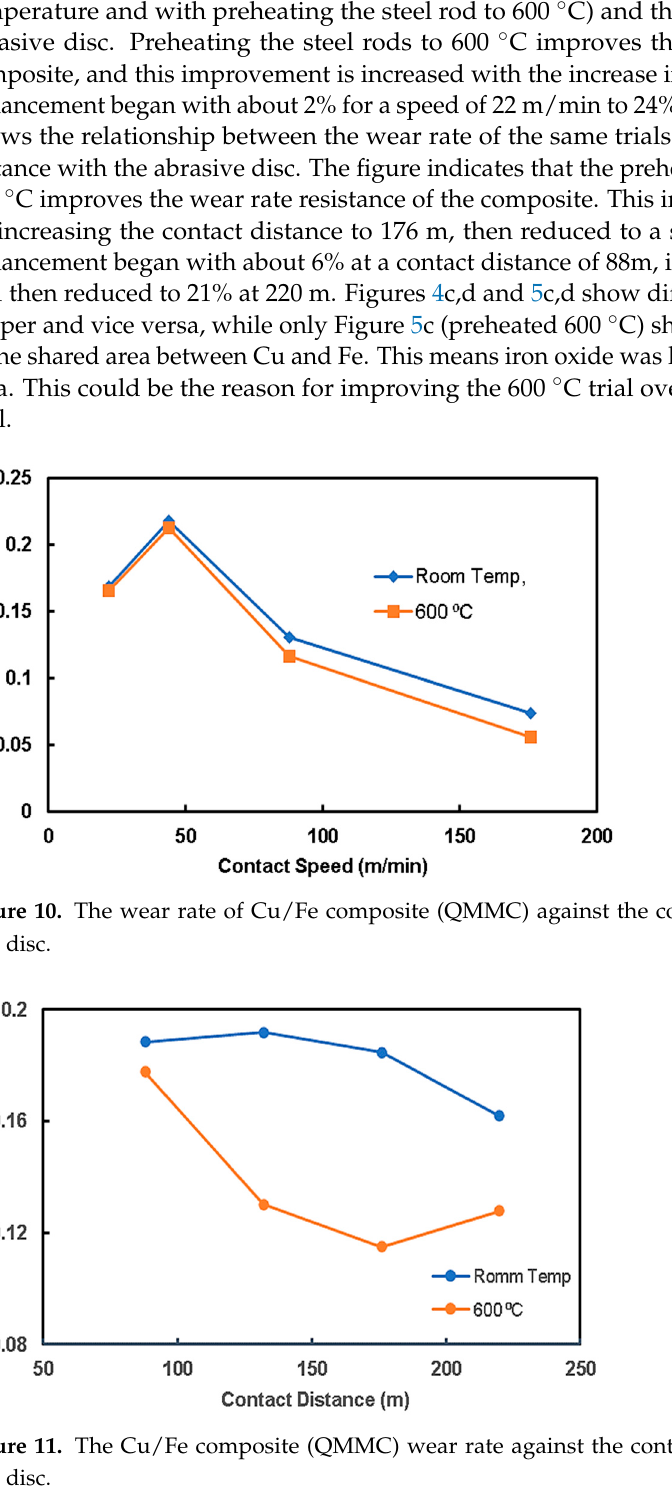
Figure 11 . The Cu/Fe composite (QMMC) wear rate against the contact distance with the abrasive disc.